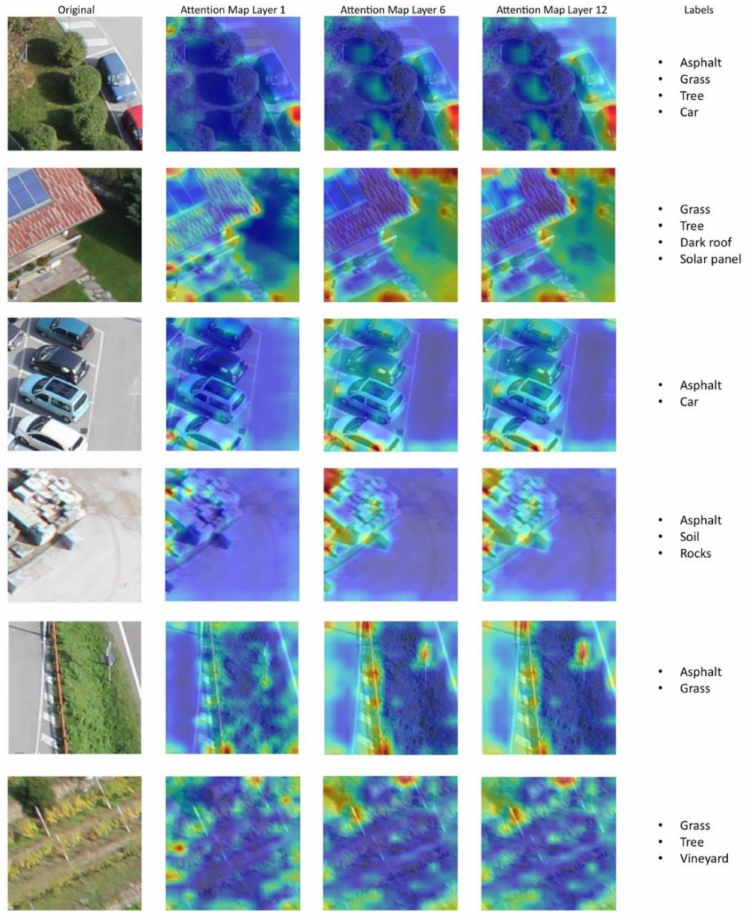
Figure 7. Attention heat maps generated by the first, sixth, and last layers of the encoder for classifying different samples from Civezzano multi-label